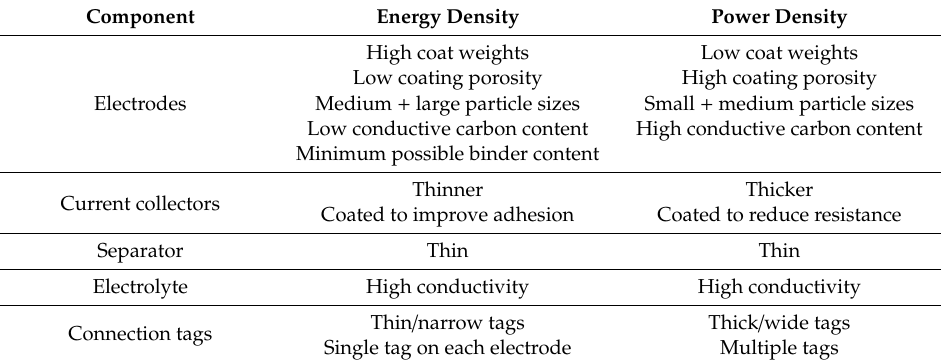
Table 1. Design parameters used to optimise lithium ion cells.